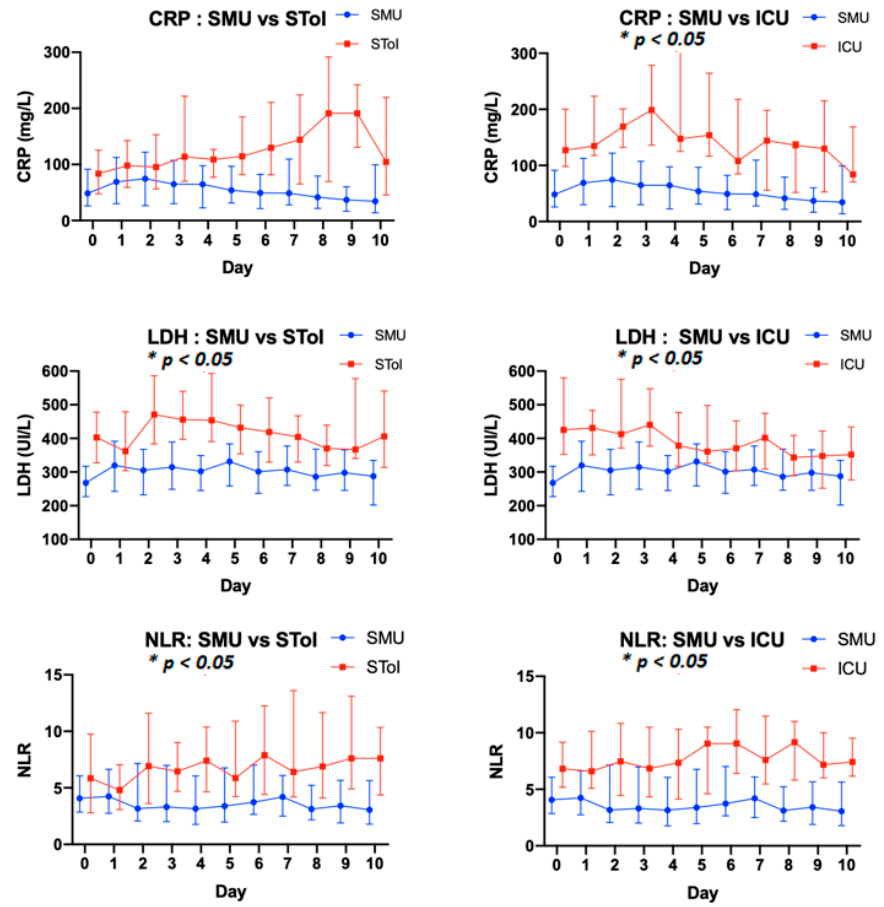
Figure 2. Kinetic following of biological parameters in training cohort (media and interquartile). Left column: Standard Medical Unit Patients vs. Standard to Intensive Care Patients groups. Right column: Standard Medical Unit Patients vs. Intensive Care Units Patients. NLR: neutrophil–lymphocyte ratio, CRP: C-reactive protein, LDH: lactate dehydrogenase. Data were expressed as mean and range. Statistical analysis was performed to compare the kinetics of biological parameters over time (Day 0 to Day 10) between groups of patients (see Statistical analysis). * p < 0.05 mean that there was a significant difference in the behavior of parameters.